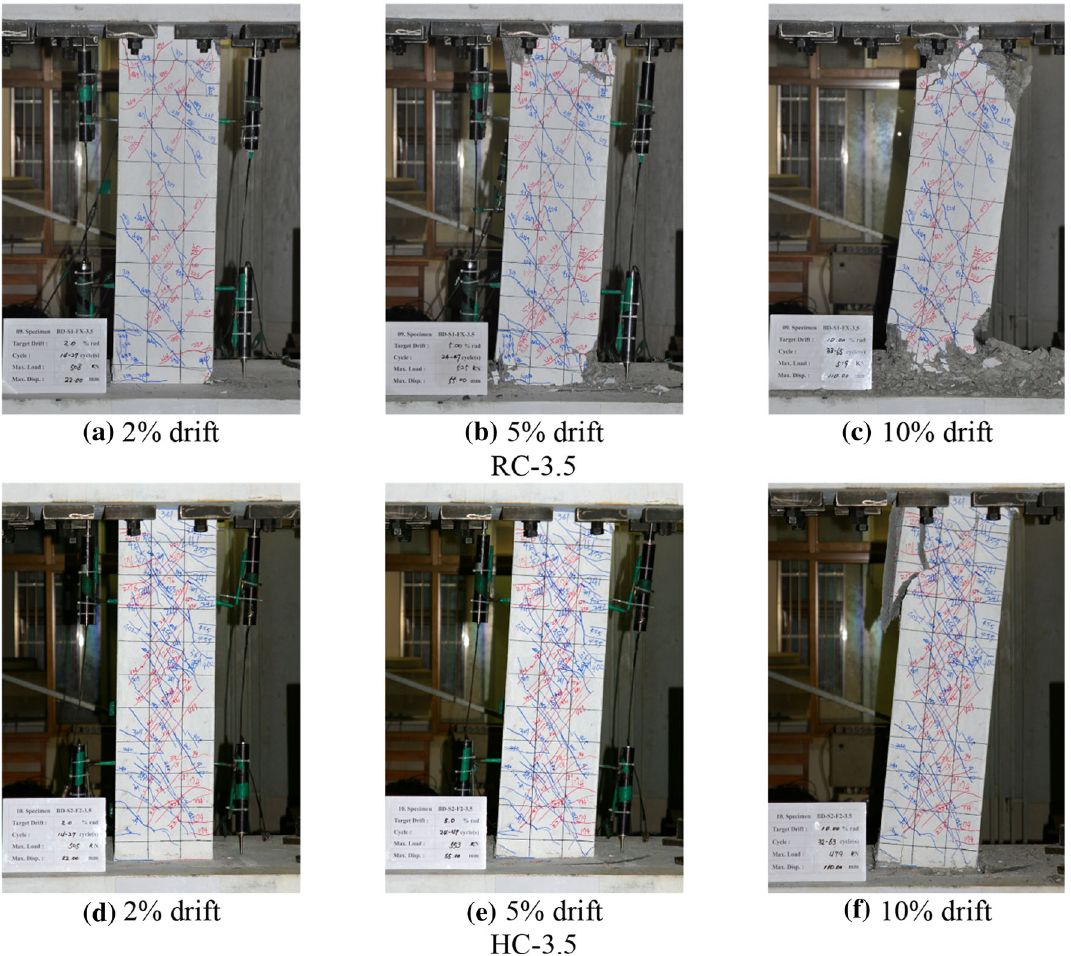
Fig. 9 Crack patterns in two specimens with aspect ratio